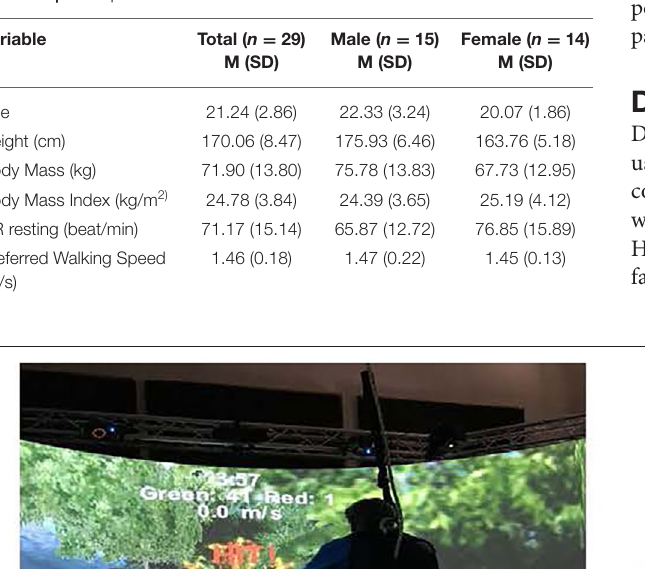
TABLE 1 | Participant Characteristics.